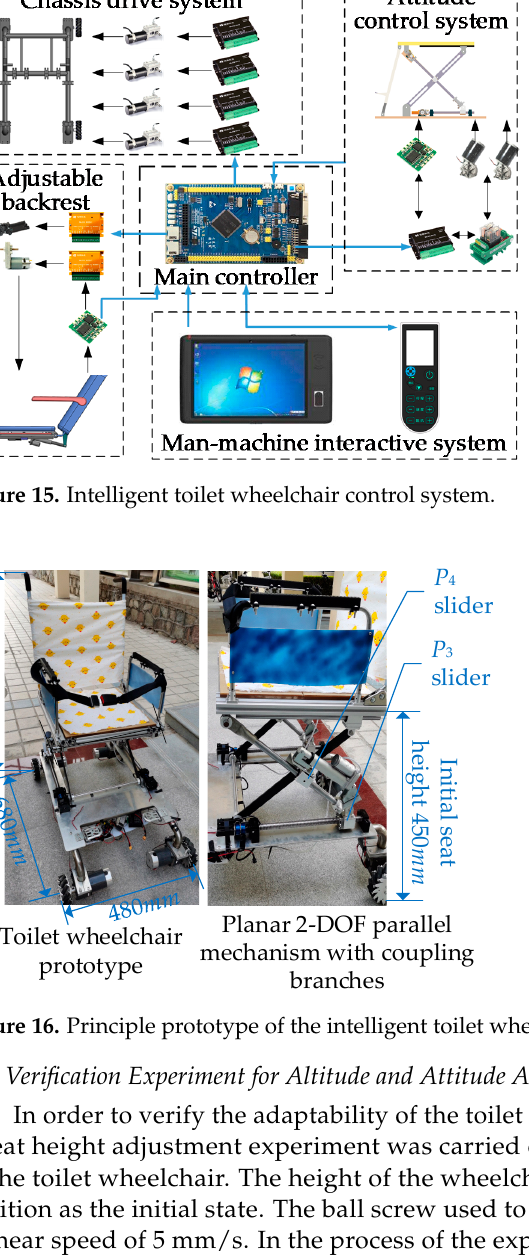
Figure 16. Principle prototype of the intelligent toilet wheelchair.